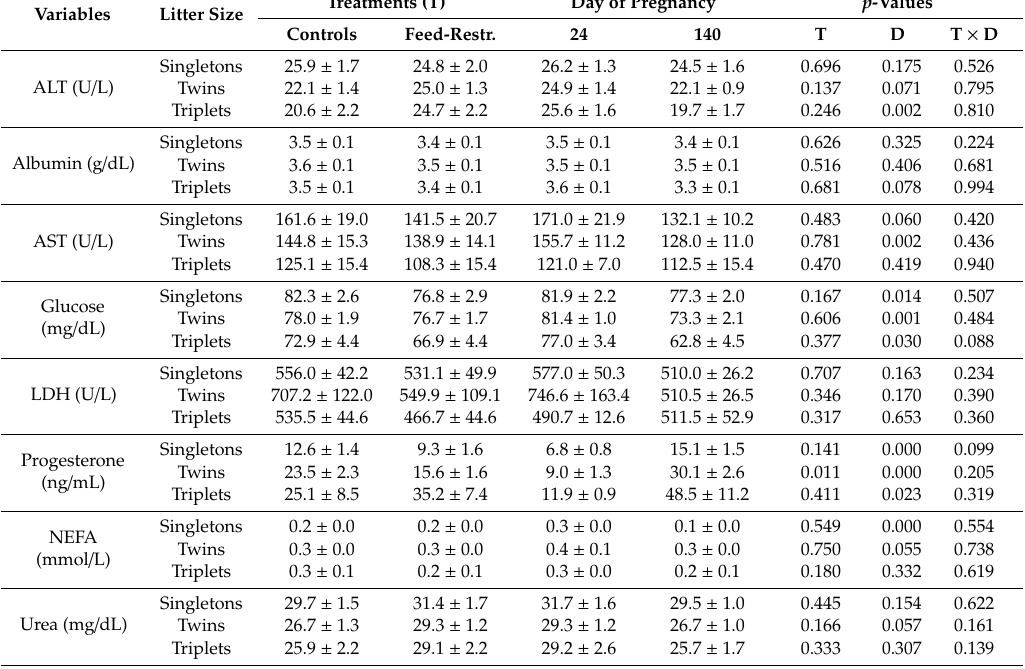
Table 4. Circulating concentrations of metabolites and progesterone at day 24 and day 140 of pregnancy in control (14singleton pregnancies, 12 twin pregnancies, and 4 triplet pregnancies) and in